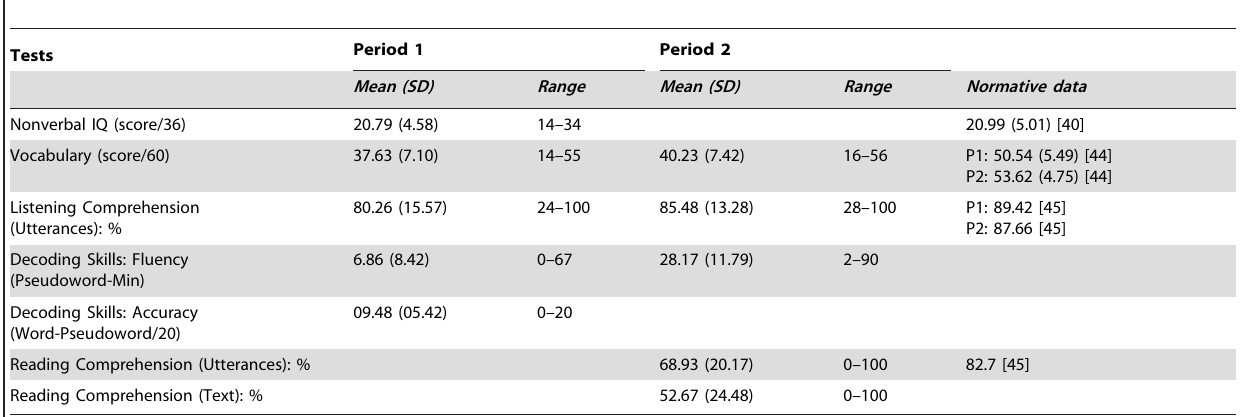
Table 1. Summary of descriptive statistics for each of the measures as function of